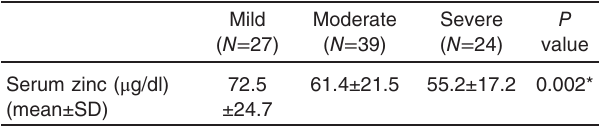
Table 4 Comparison of serum zinc level according to the degree of respiratory distress among patients ( N =